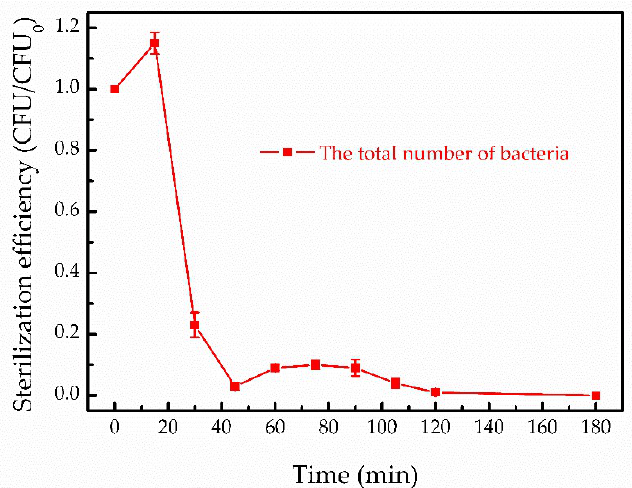
Figure 9. Fenton-like and chlorine combined disinfection experiment results.